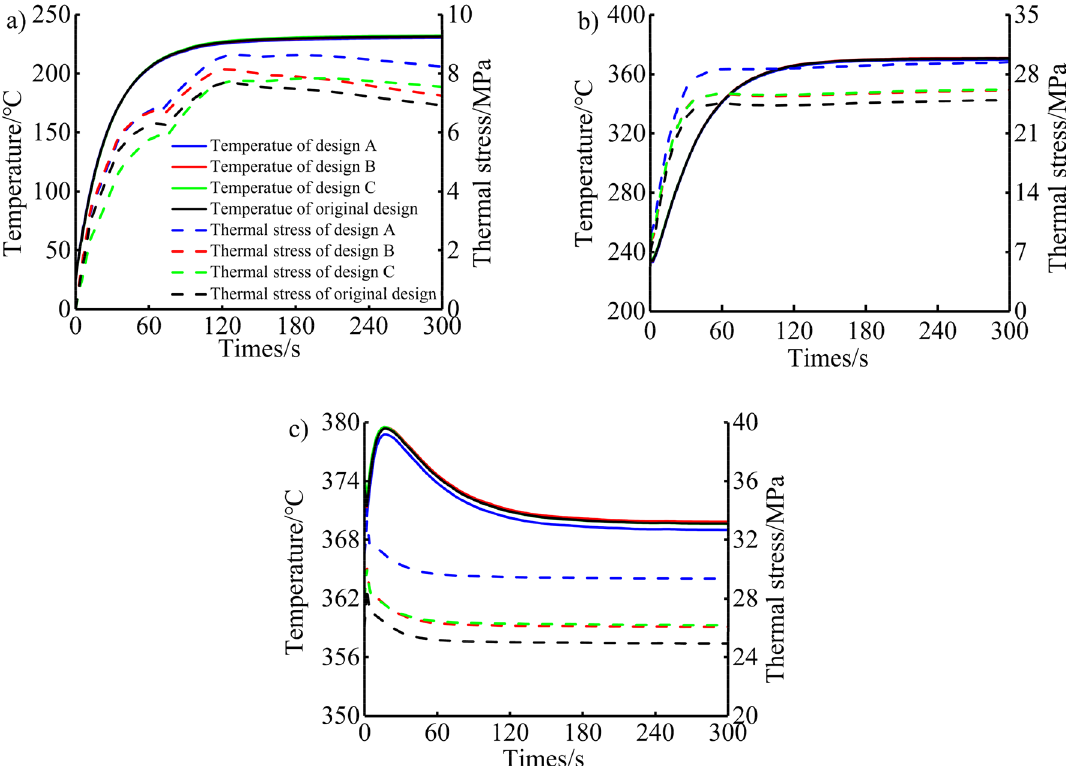
Figure 15. Temperature and thermal stress distribution of throat under the ( a ) cold start condition, ( b ) urgent acceleration condition and ( c ) rapid deceleration condition.